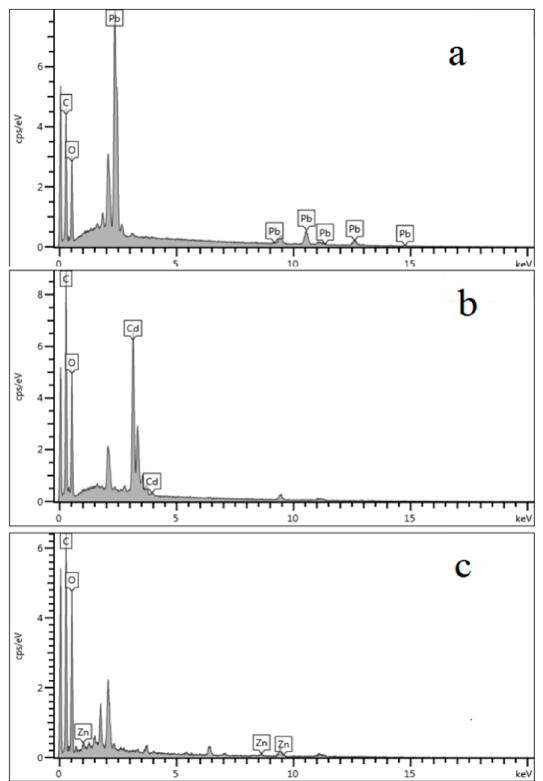
Figure 6. Energy dispersive X-ray (EDX) of the hydrogels after adsorbing the heavy metal ions ( a ) Pb 2+ , ( b ) Cd 2+ , and ( c ) Zn 2+ .